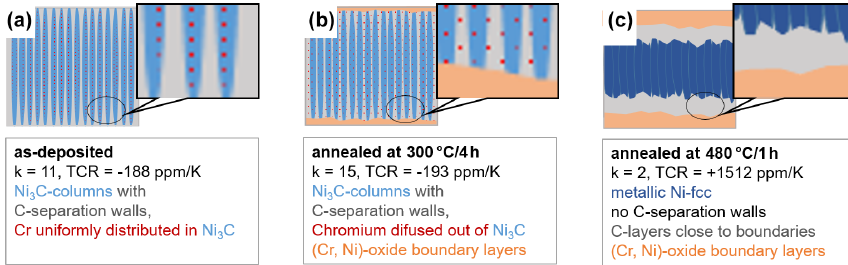
Figure 6. Model sketches of Ni 90 Cr 10 -C films after different annealing treatments. (a) as-deposited (b) after annealing at 300 ◦ C per 4h (c) after annealing at 480 ◦ C per 1h. The electrical properties and structural microscopic features, derived from the TEM element distribution measurements, are noted in the boxes. Further explanations are given in the text.